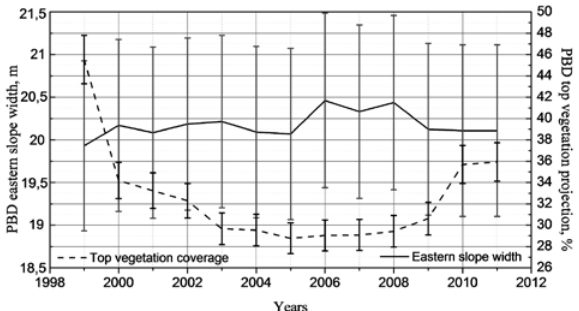
Fig. 5. Changes of PBD eastern slope width and PBD top vegetation coverage